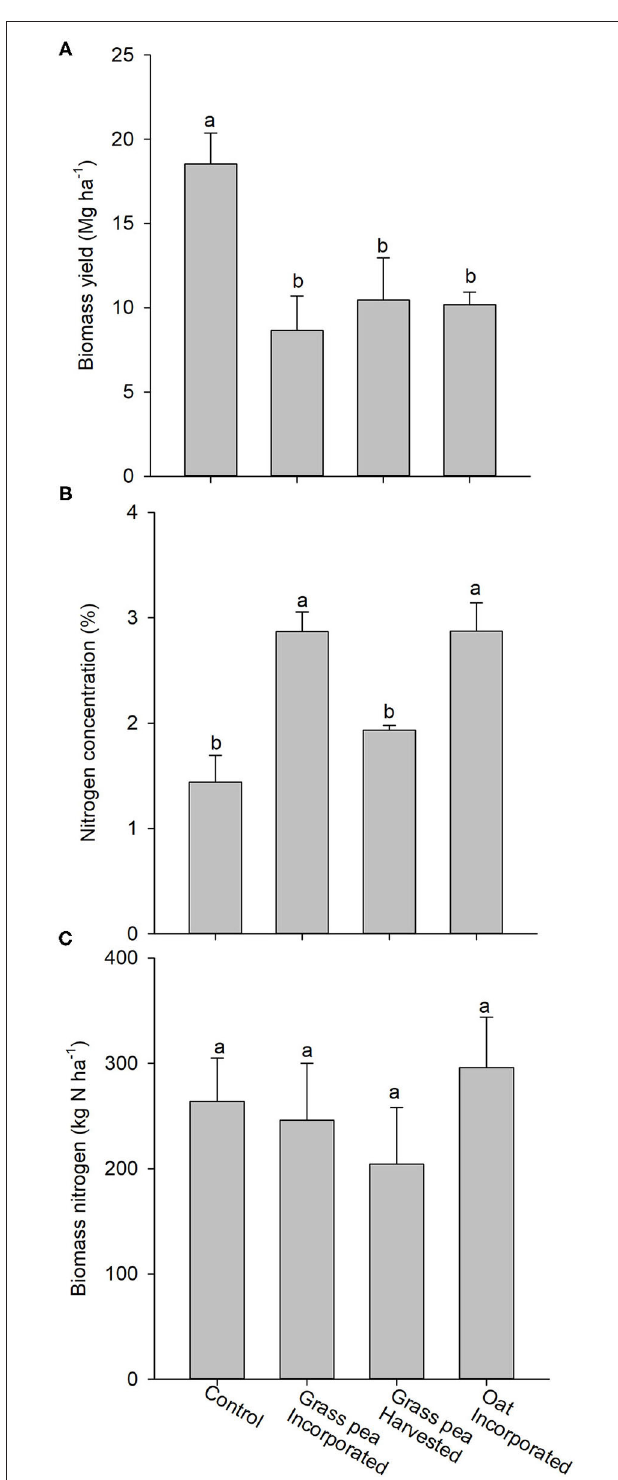
FIGURE 5 | (A) Mean aboveground biomass produced by crabgrass after 90 days of growth. (B) Nitrogen (N) concentrations of the harvested biomass of crabgrass. (C) Total amount of N in the harvested crabgrass biomass. Error bars represent standard error ( n = 3). Different letters on the top of bars indicate statistical difference ( P <